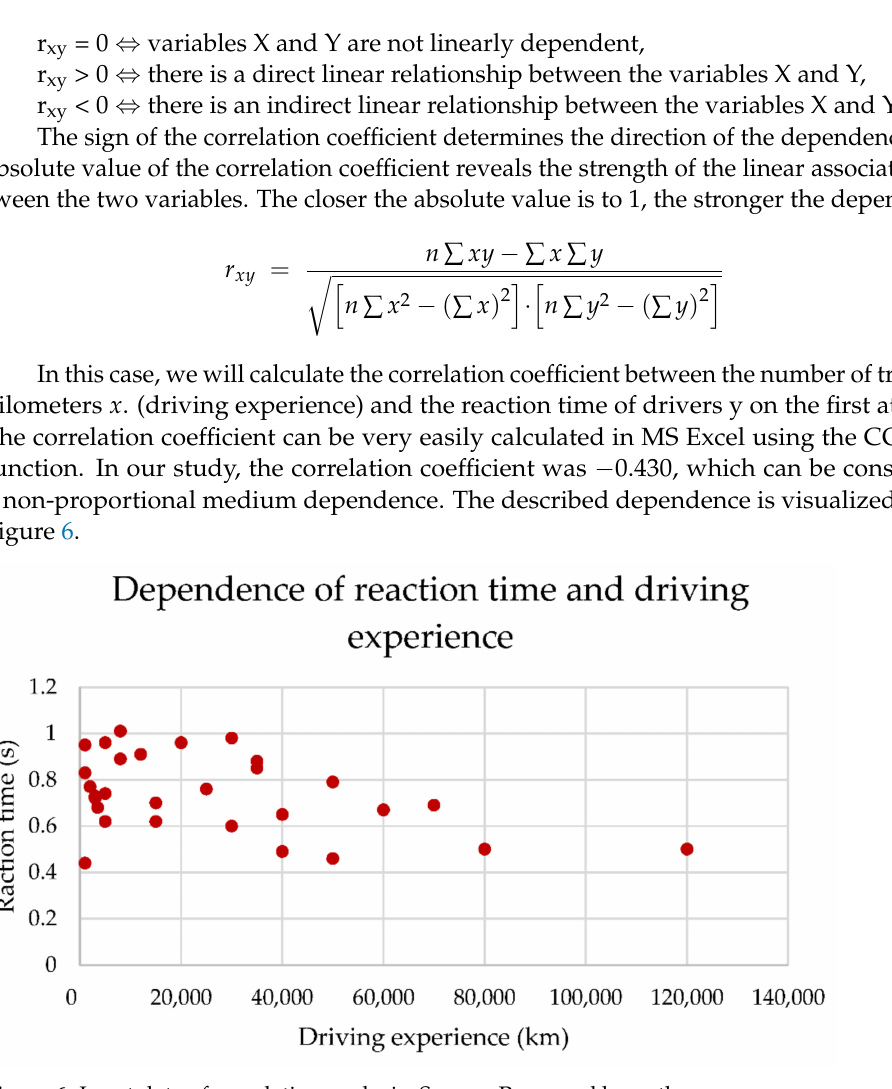
Figure 6. Input data of correlation analysis. Source: Processed by